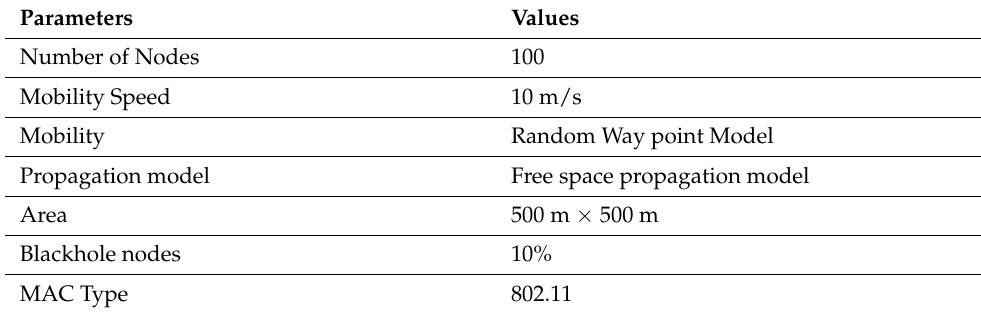
Table 1. Simulation parameters.